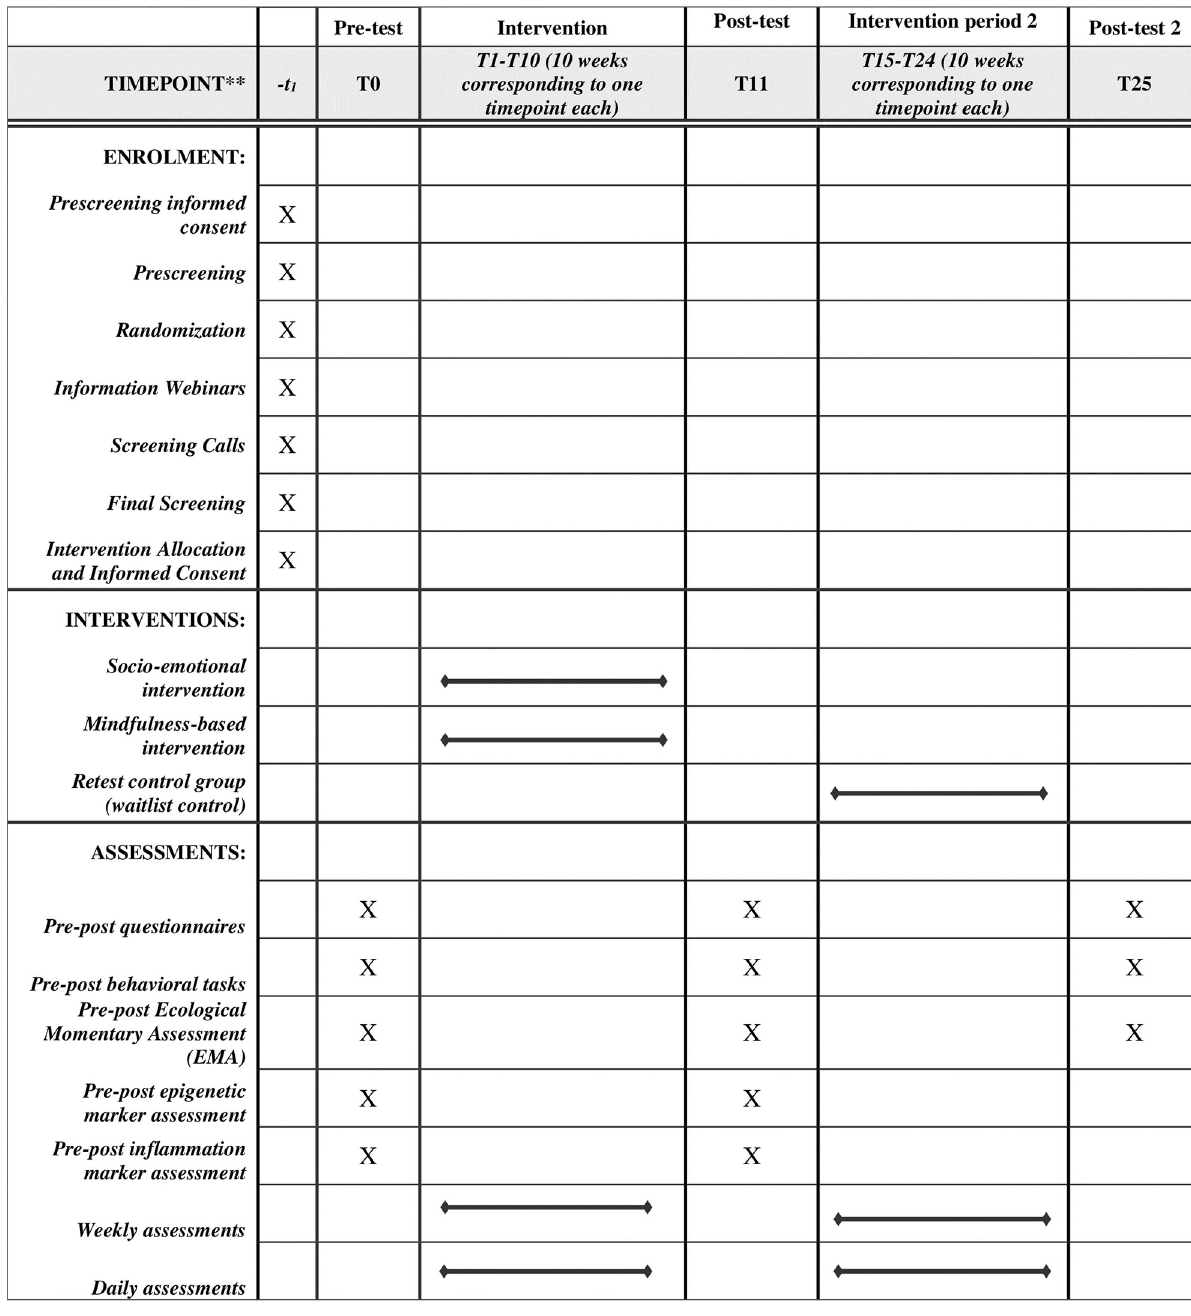
Fig 2. An overview of the schedule of enrollment, interventions, and